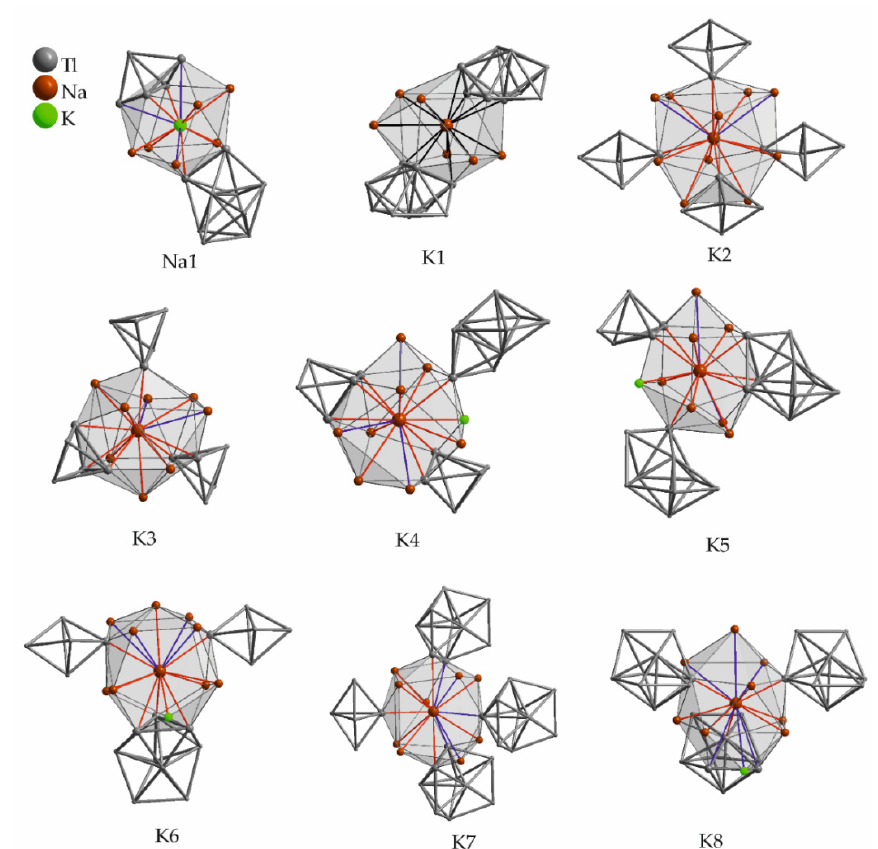
Figure 11. Atomic environment of the symmetry inequivalent sodium and potassium positions in Na 2 K 21 Tl 19 . The corresponding range of distances to the adjacent atoms as well as the Wyckoff letters are given in Table 13. Shorter contacts are colored red, longer distances are given in blue, the color coding is also used in the corresponding table.